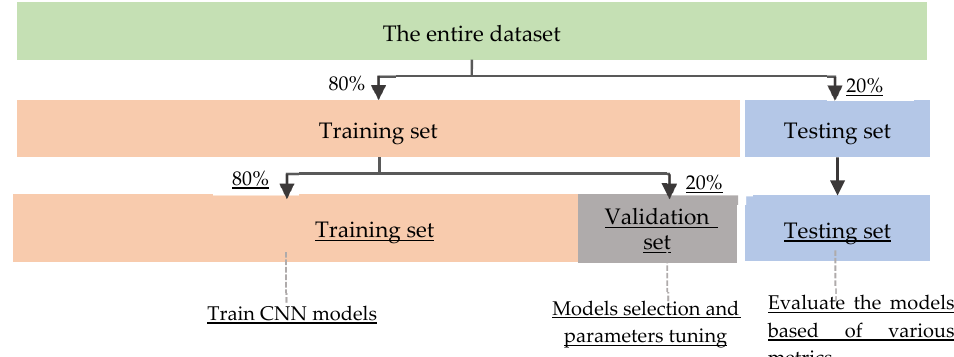
Figure 15. Data partition and training of CNNs using holdout strategy.